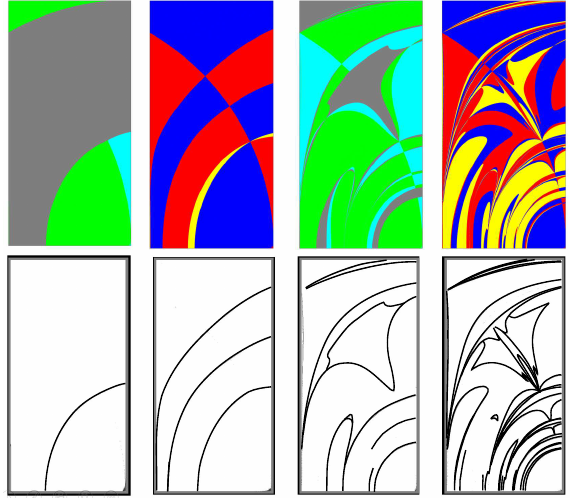
Fig. 10. Binary collision curves can be revealed by the borders separating different colors. Triple collisions can be revealed as “corners” with three